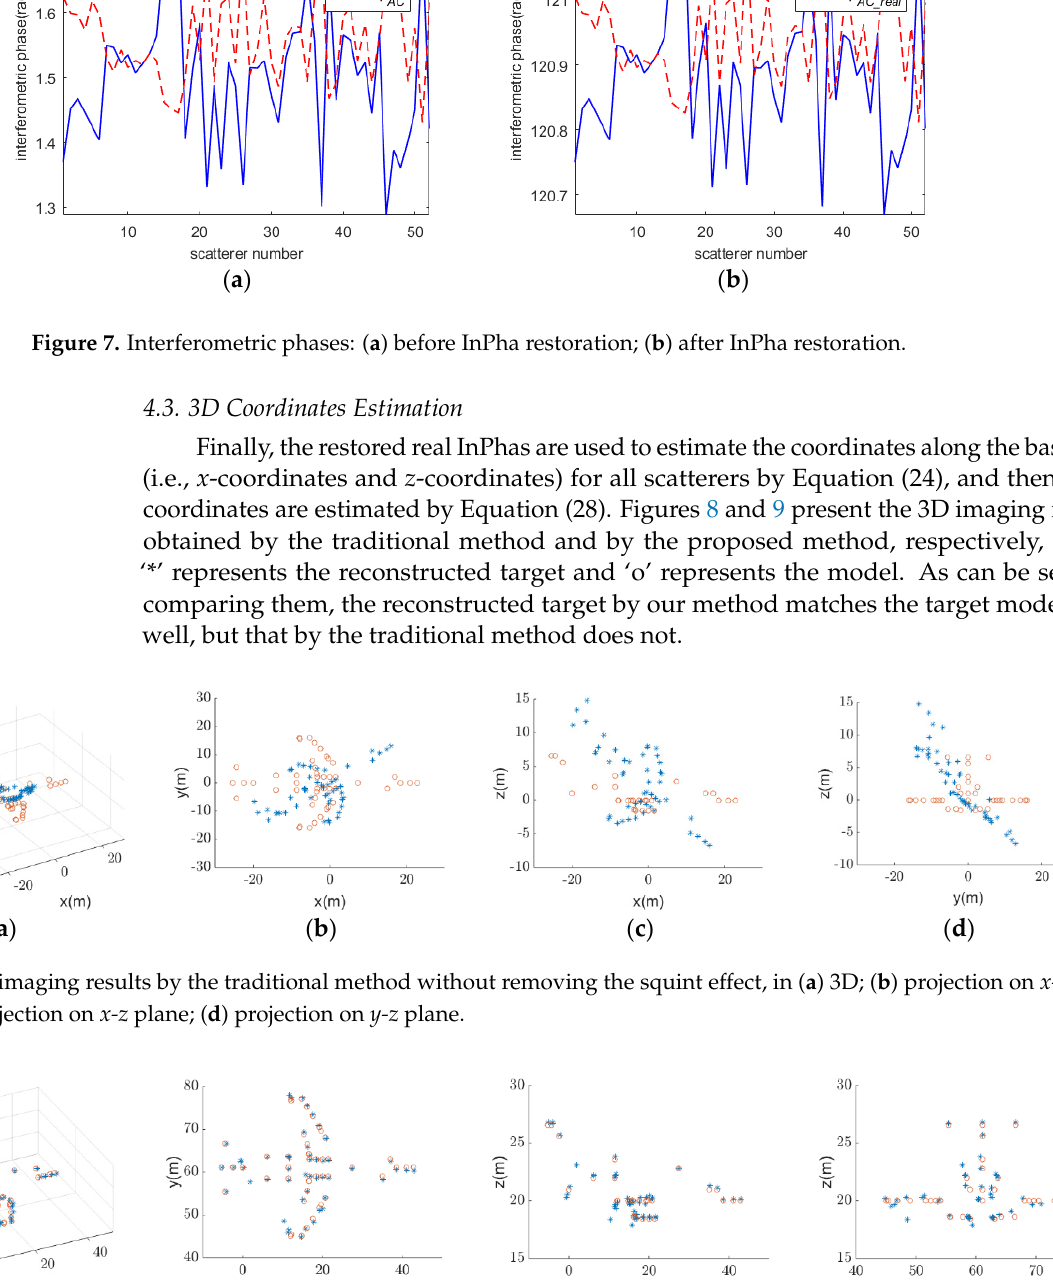
( c ) Figure 6. ISAR images of antenna A obtained by ( a ) the proposed method; ( b ) the method in [25] by taking Q as the reference scatterer; ( c ) the method in [25] by taking the target center as the reference scatterer. Table 2. Comparison of image entropy and contrast. Image Entropy